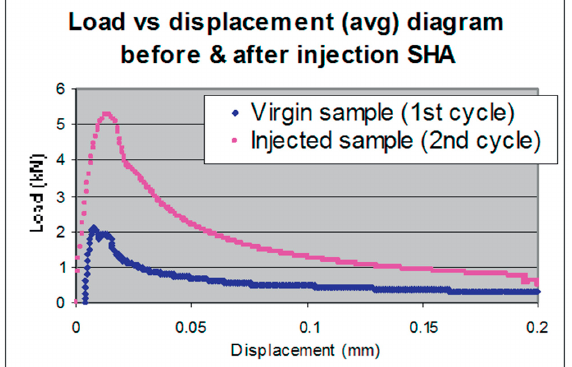
Figure 14. Average tensile load–displacement diagram of a virgin (blue curve) and a healed concrete sample after injection of a self-healing agent (SHA) (red curve). Reprinted from [71], Copyright 2013, with permission from Elsevier.